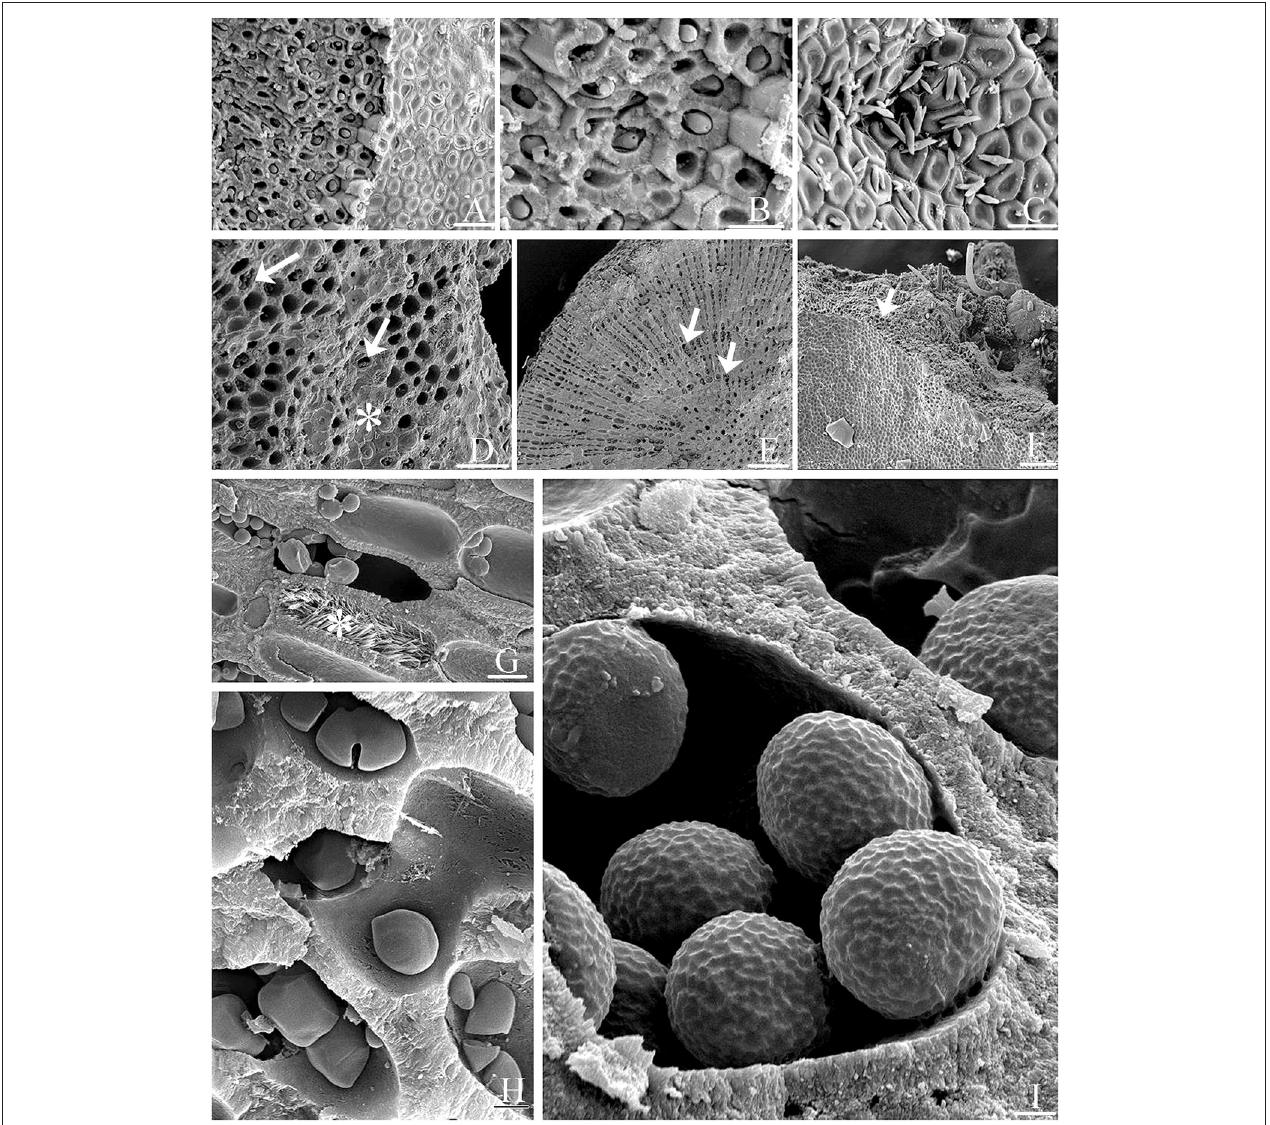
FIGURE 6 | Epilithic microalgae and various endolithic cellular inclusions of unknown taxonomic identity in biogenic rhodoliths. (A) Biogenic rhodolith surface (epithallus, at right) revealing underlying perithallus (at left) with endolithic cellular inclusions within calcium carbonate-enclosed cell lumina. Scale bar = 10 µ m. (B) Close-up of (A) Scale bar = 20 µ m. (C) Free-living microalgae on rhodolith surface Scale bar = 14 µ m. (D) Surface cells (asterisk), and underlying exposed perithallial cells. Epithallial cells (asterisk) have been partly removed exposing endolithic cellular inclusions (arrows) in some perithallial cells. Scale bar = 5 µ m. (E) Transverse view of rhodolith nodule showing endolithic cellular inclusions (arrows) within perithallial cells. Scale bar = 200 µ m. (F) Surface (epithallus, at left) and fractured perithallus (in center, arrow) with cellular inclusions, and with burrowing taxa (at top). Scale bar = 300 µ m. (G) Perithallial cells filled with aragonite crystals (asterisk), or endolithic cells. Scale bar = 20 µ m. (H) Perithallial cells filled with endolithic cells. Some endolithic cells reside in perithallial fusion cells. Scale bar = 0.5 µ m. (I) Endolithic cells showing surface ornamentation within perithallial cells. Scale bar = 0.7 µ